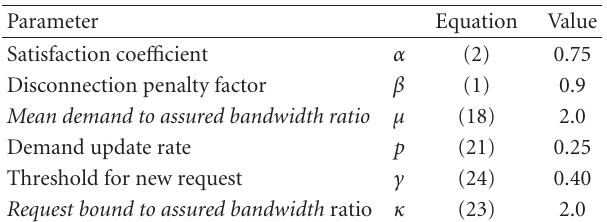
Table 1: The simulation configuration.